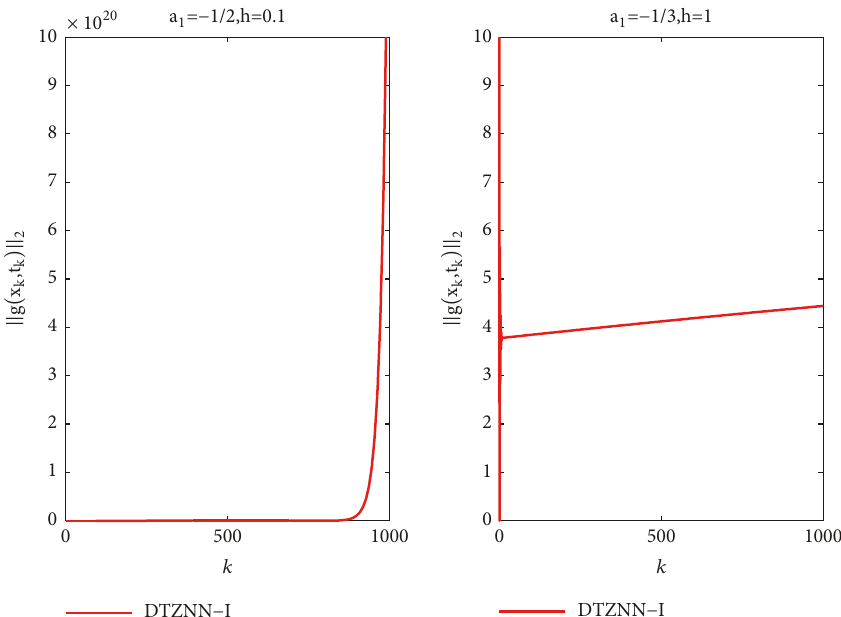
Figure 5: Trajectories of SSRE ‖𝑔(𝑥 𝑘 , 𝑡 𝑘 )‖ 2 generated by the DTZNN model (18) for problem (50).